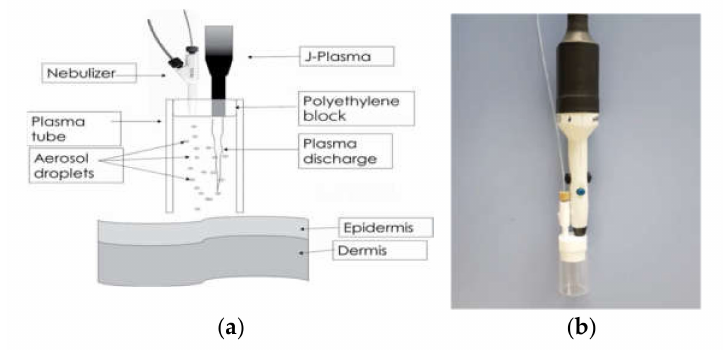
Figure 10. ( a ) schematic of plasma chamber with integrated nebulizer designed to fit onto a plasma jet, and, ( b ) corresponding picture of the device. Reprinted with permission from [68]. Copyright 2018 Begell House,